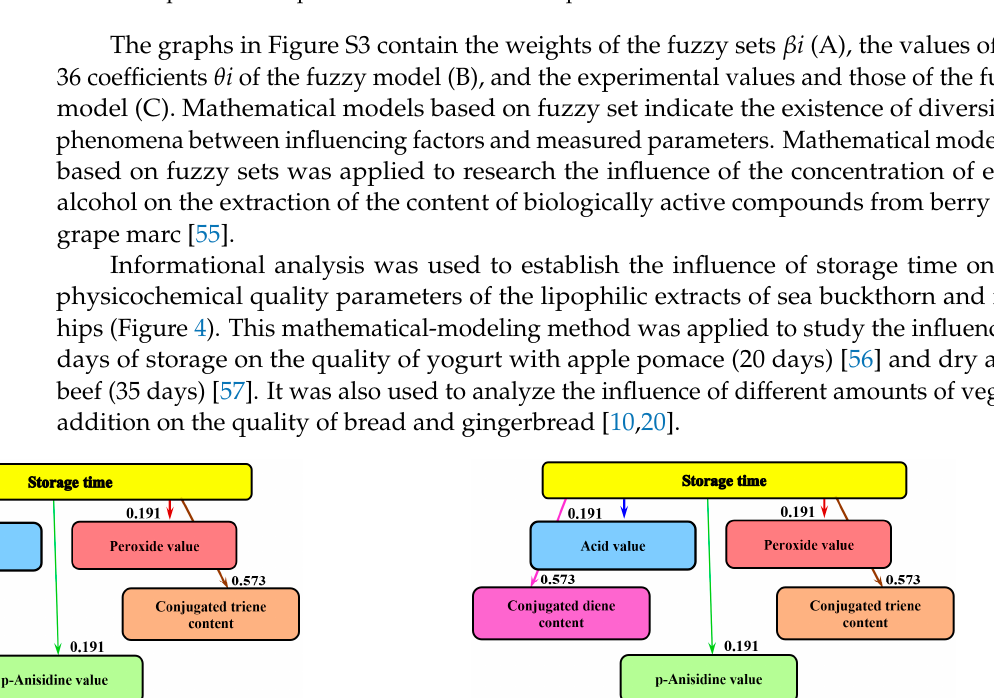
Figure 3. Generalized fuzzy mathematical model (PV = f (t, AV)) for sunflower oil, sea buckthorn, and rose hip extracts: experimental values and computational surface.